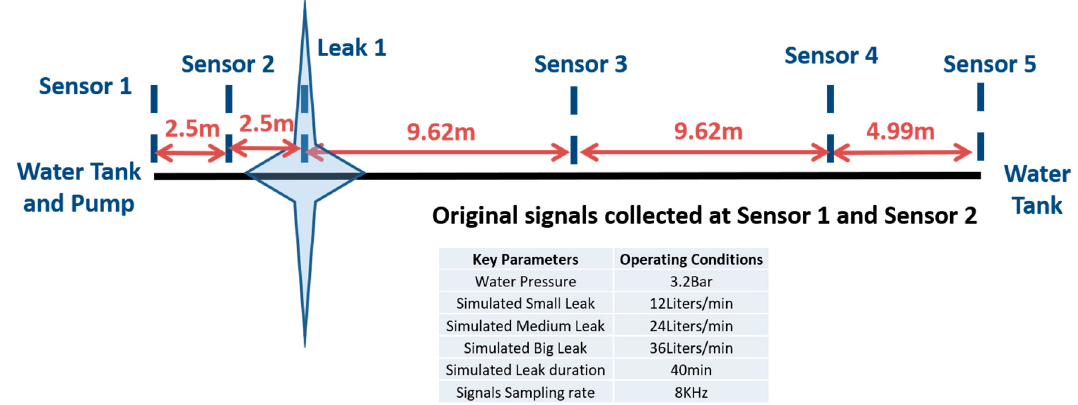
Figure 8. Schematic of testbed for water leakage detection system.